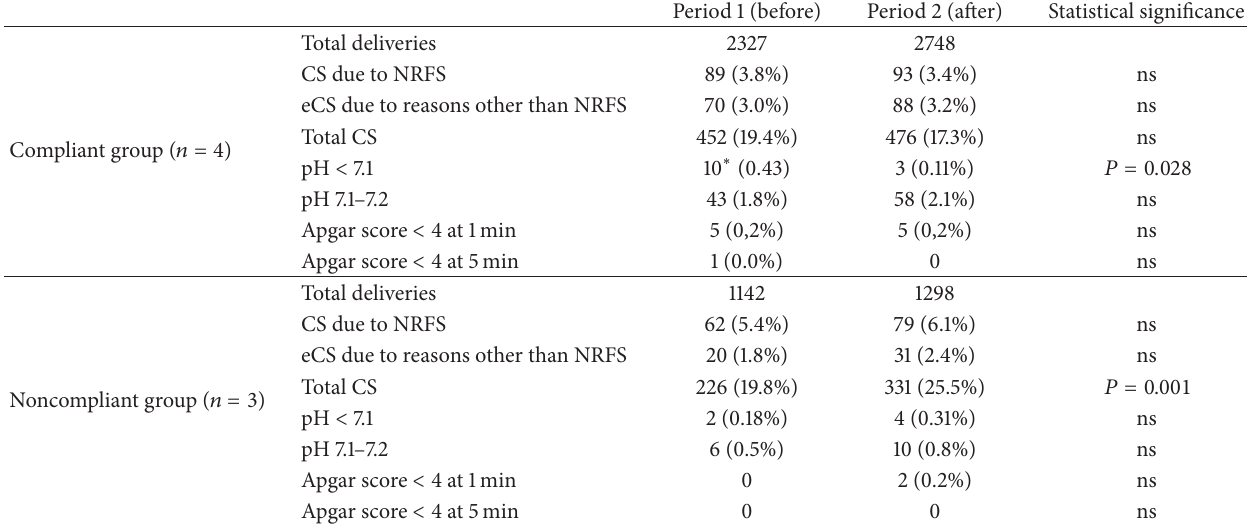
Table 2: The incidence of low pH values and cesarean births before and after the introduction of FHR centralization in the compliant and noncompliant